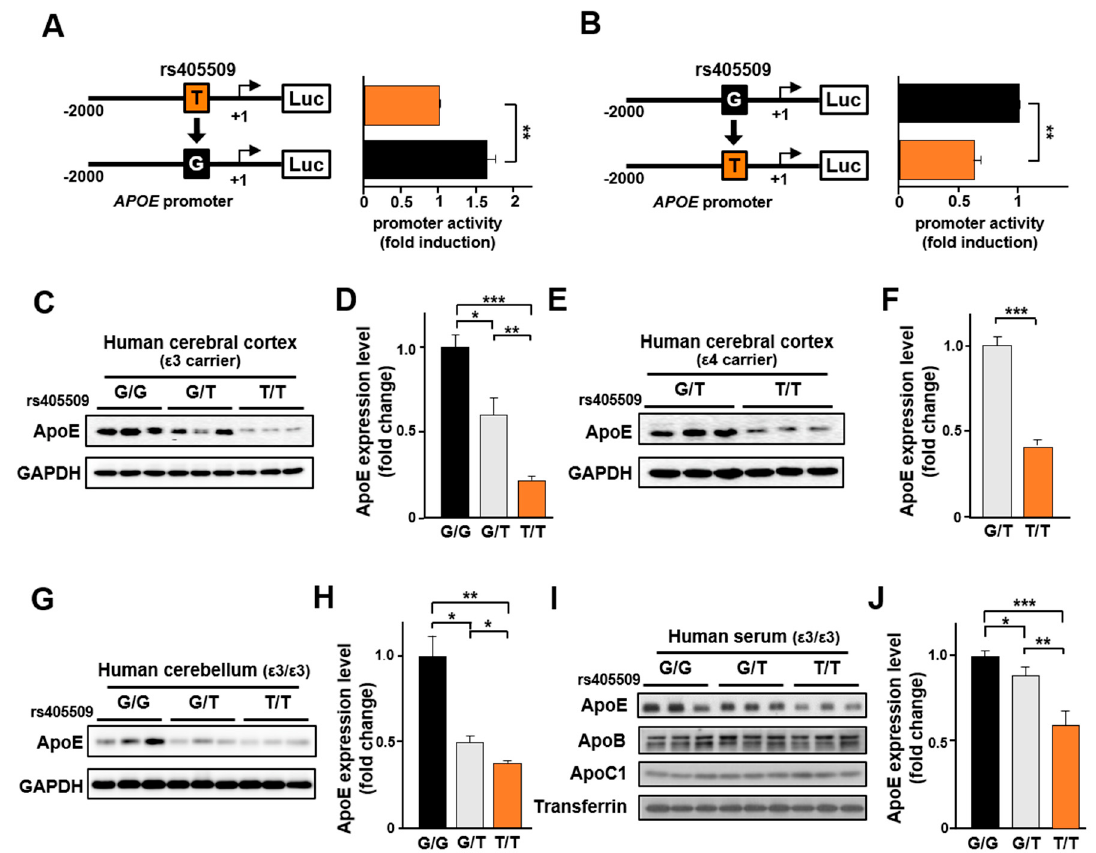
Figure 4. The rs405509 T-allele reduces APOE expression. To investigate whether rs405509 alleles directly affect the APOE expression, the APOE promoter region was subjected to a reporter gene assay. APOE promoter DNA fragments were cloned from an AD patient ( A ) and a cognitively normal control subject ( B ). The rs405509 T -allele was changed to a G allele by site-directed mutagenesis ( A ) and vice versa ( B ). The horizontal bar graphs show the relative intensities of APOE promoter activity. Data represent mean ± SEM ( n = 5, ** p < 0.01). ( C – J ) The rs405509-dependent apoE protein level was assessed in human brain tissue and serum. ( C , E , and G ) Cerebral cortical and cerebellar tissues were subjected to Western blotting with anti-apoE and anti-GAPDH antibodies to investigate rs405509 genotype-dependent expression levels of apoE in the brain. The cerebral cortical tissues in panel C were from ε 3 homozygotes except for one ε 2 / ε 3 individual (lane 1). The cortical tissues in panel E were from individuals with ε 3 / ε 4 (lanes 1, 2, 4, and 5) or ε 4 / ε 4 (lanes 3 and 6) genotypes. All cerebellar tissues in panel G were from ε 3 homozygotes. ( D and H ) Relative expression of APOE in cerebral cortex and cerebellum among ε 3 carriers stratified by rs405509 genotype ( G / G , G / T , and T / T ) with G / G used as the reference and GAPDH used as a normalized control. Data represent mean ± SEM. ( F ) Relative expression of APOE in cerebral cortex among ε 4 carriers stratified by rs405509 genotype ( G / T and T / T ) with G / T used as the reference and GAPDH used as a normalized control. Data represent mean ± SEM. ( I ) Blood samples were subjected to Western blotting with anti-apoE, anti-apoB, anti-apoC1, and anti-Transferrin antibodies to investigate rs405509 genotype-dependent expression of apoE. ( J ) Relative expression of apoE in human serum among ε 3 / ε 3 individuals stratified by rs405509 genotype with G / G used as the reference. Data represent mean ± SEM. * p < 0.05, ** p < 0.01, *** p < 0.001. Abbreviations: ApoE, Apolipoprotein E; ApoC1, Apolipoprotein C1; ApoB, Apolipoprotein B; GAPDH, Glyceraldehyde-3-Phosphate Dehydrogenase.